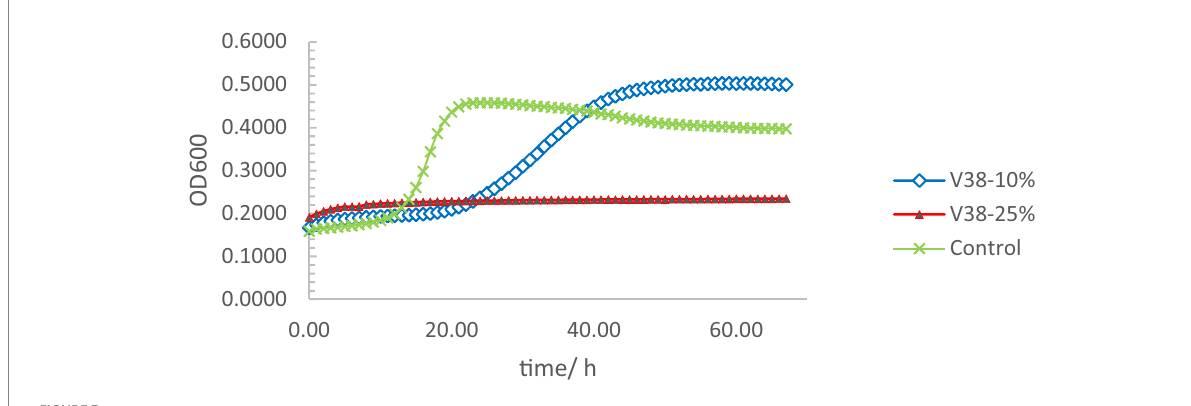
FIGURE 3 Growth curves of S. mutans under different supernatant concentrations.